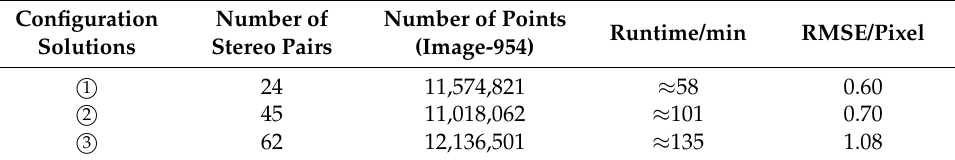
Table 2. Comparative results for all three